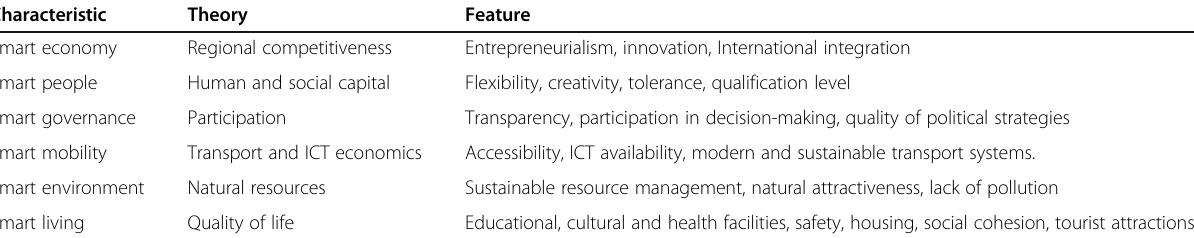
Table 2 Smart city characteristics [14] Characteristic